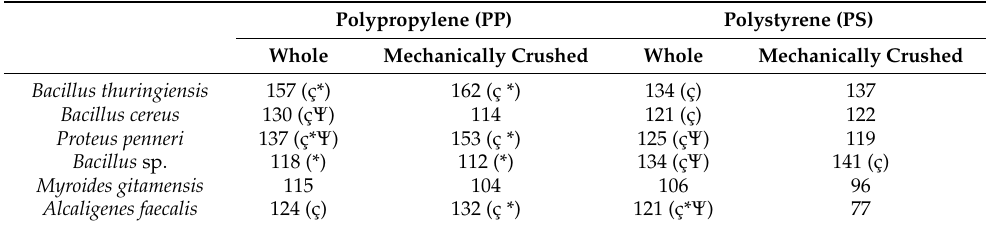
Table 3. Bacteria growth (in percentages, %) over whole and mechanically crushed polymer spheres made of polypropylene (PP) and polystyrene (PS) after one year in culture. Polypropylene (PP) Whole Mechanically Crushed Whole Mechanically